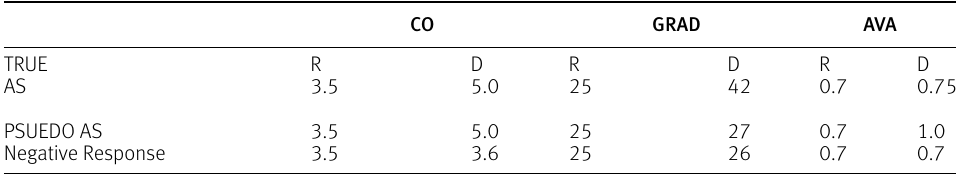
Figure.2 Leftventricular(LV)andfemoralartery(FA)tracings(leftpanel)arecomparedwithpressurerecordings from LV and aorta (right panel) in the same patient with AS. Time delay and pressure recovery cause the LV-FA recording to severely underestimate the true transvalvular gradient. Table 2. Potential responses to dobutamine in aortic stenosis patients with low gradient, low ejection